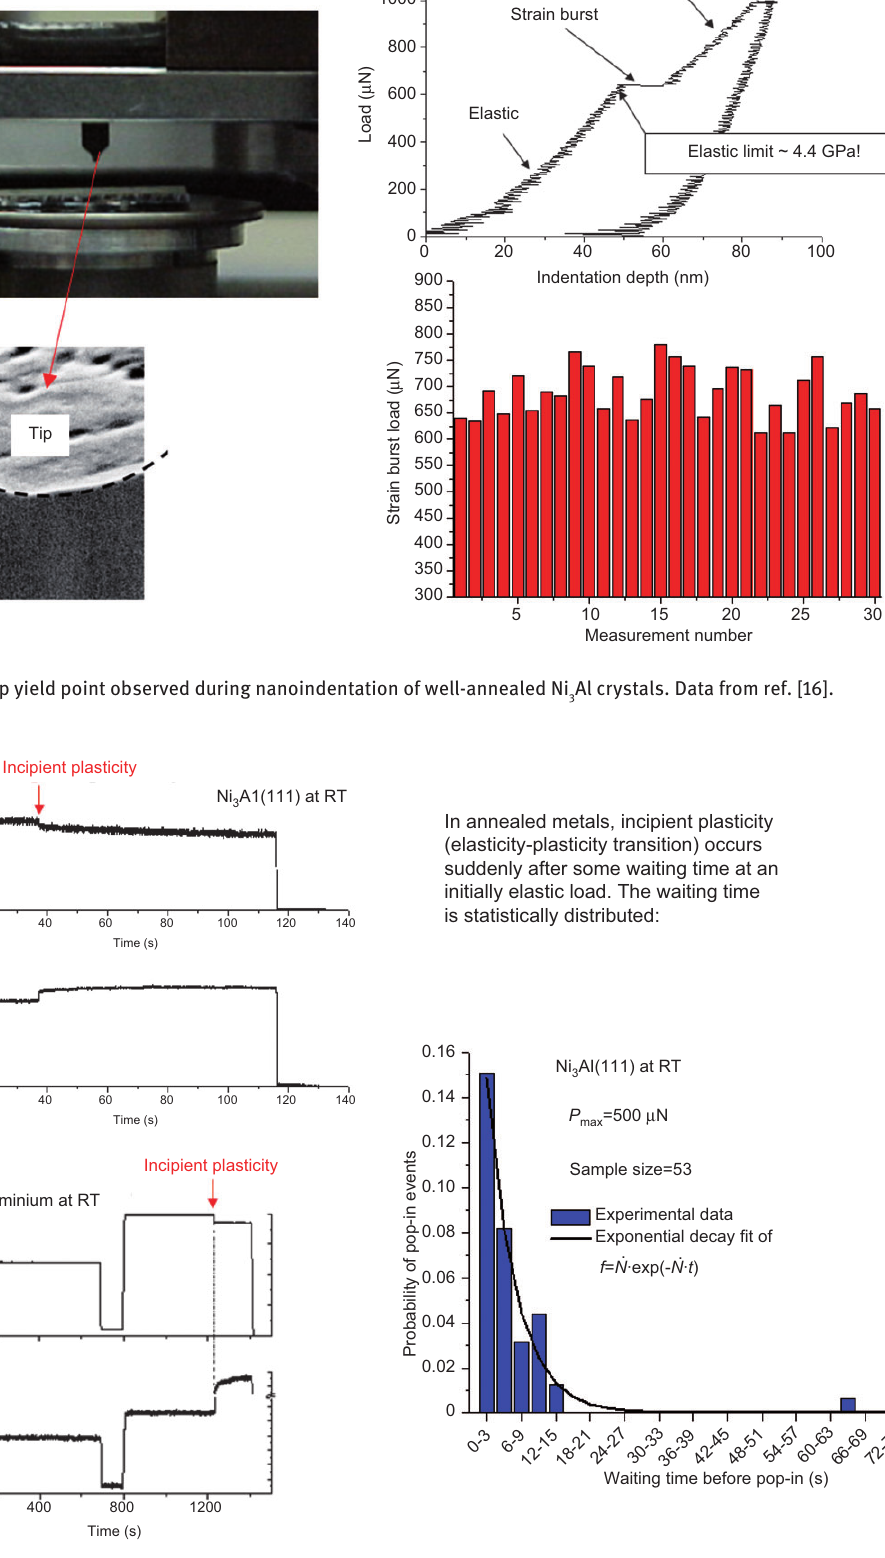
Al crystals. Data from ref. [16] 3